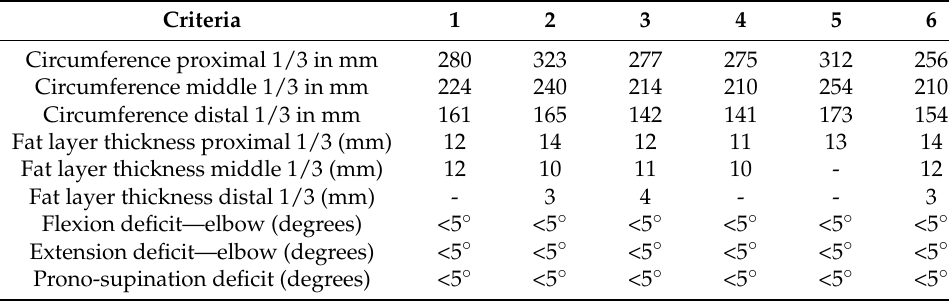
Table 4. Anatomical characteristics of healthy forearms.